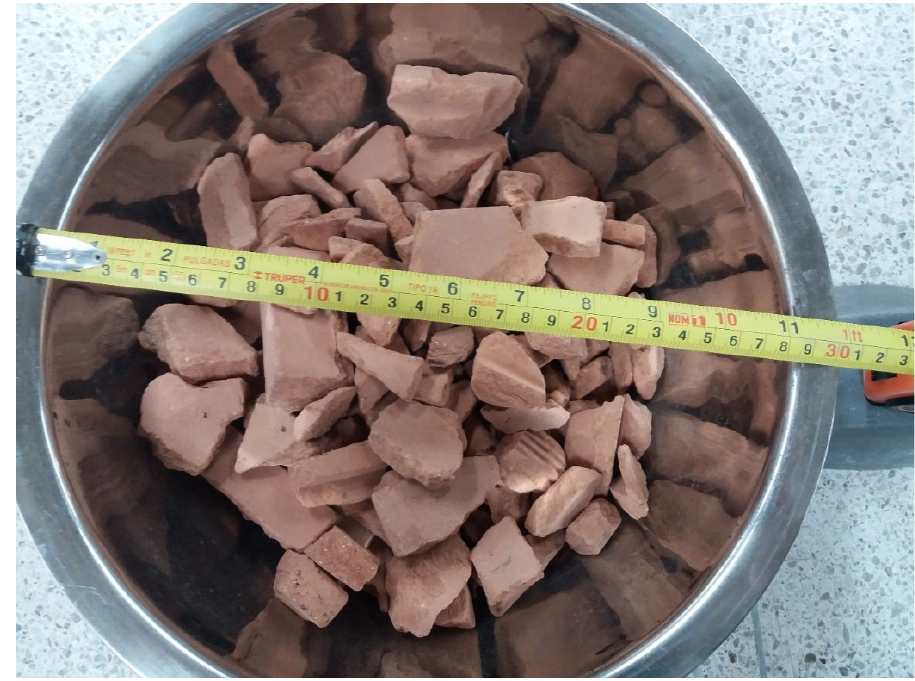
Figure 1. Brick waste (own